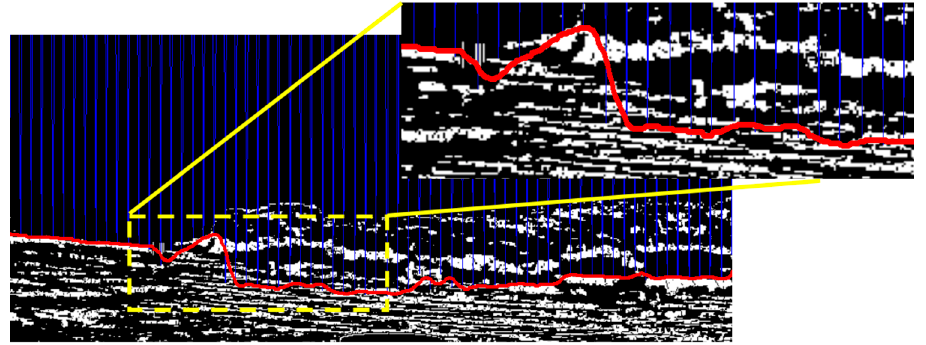
Figure 10. The result of the first segmentation.